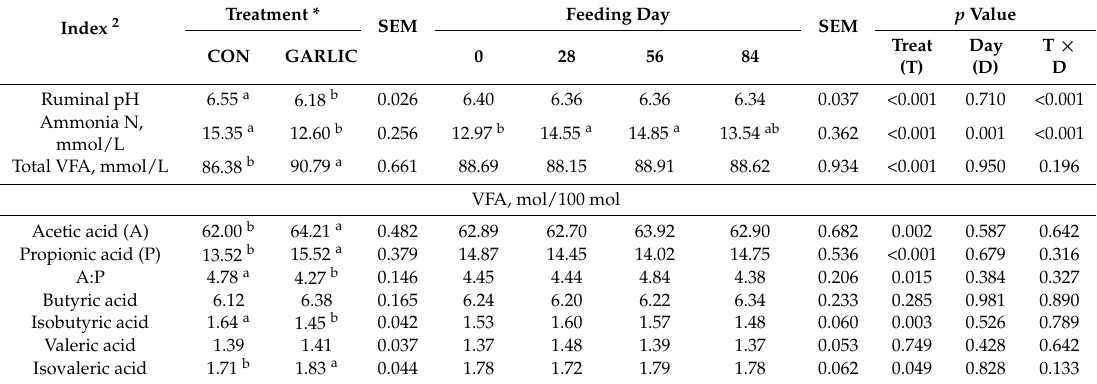
Table 3. Effects of dietary garlic powder supplementation on rumen fermentation parameters of lambs infected with gastrointestinal nematodes.